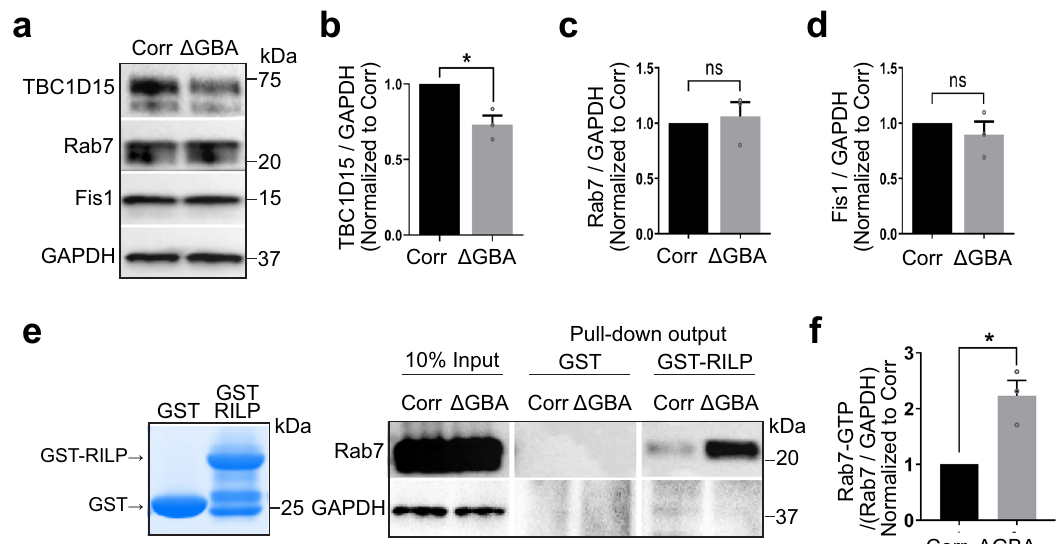
Fig. 4 Tethering proteins mediating mitochondria – lysosome contact are disrupted in GBA1 -PD patient dopaminergic neurons. a – d Western blot analysis of b TBC1D15, c Rab7, and d Fis1 levels in PD patient-derived mutant GBA1 dopaminergic neurons ( Δ GBA) and its CRISPR-corrected isogenic control (Corr) neurons. Protein levels were normalized to loading control GAPDH. Values are expressed as fold-change compared to Corr ( N = 3 independent experiments). Paired two-sided Student ’ s t -test; * p = 0.0442. e , f GST-RILP pull-down to measure GTP-bound Rab7 levels in Δ GBA and Corr neurons. f Rab7-GTP levels were normalized to total Rab7 normalized to GAPDH. Values are expressed as fold-change compared to Corr ( N = 3 independent experiments). Paired two-sided Student ’ s t -test; * p = 0.0478. For all quanti fi cations, data are means± S.E.M., * p ≤